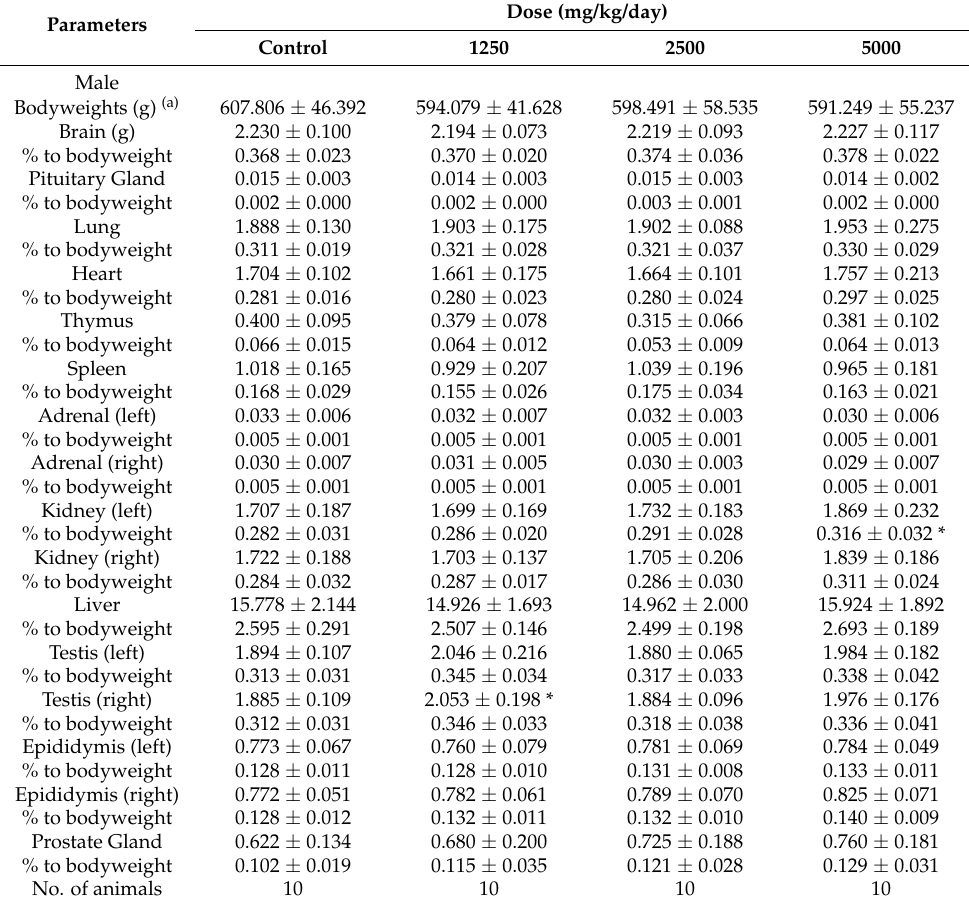
Table 11. Absolute and relative organ weights in 13 weeks repeated oral dose toxicity of WG extract in male